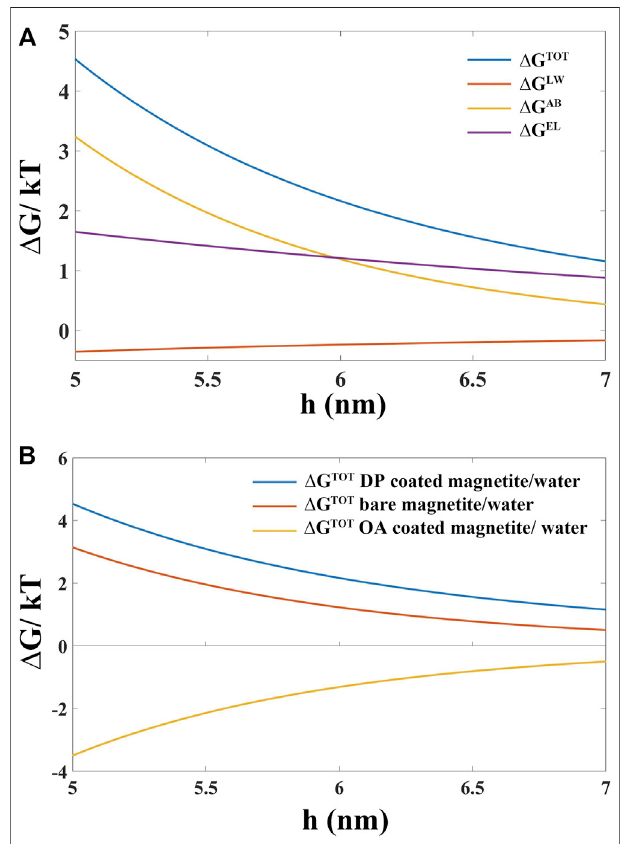
FIGURE 9 | (A) Interfacial distance (h) dependence of total surface interaction free energy ( Δ G TOT 131 ) , Lifshitz-van der Waals part ( Δ G LW 131 ) , acid- base interaction part ( Δ G AB 131 ) , and electrical part ( Δ G EL 131 ) of interfacial Gibbs free energy between magnetic particles coated by DP under water- based neutral condition (pH = 7). (B) Interfacial distance (h) dependence of total surface interaction free energy ( Δ G TOT sws ) of DP-coated magnetite, bare magnetite, and OA-coated magnetite in the neutral water-based colloidal